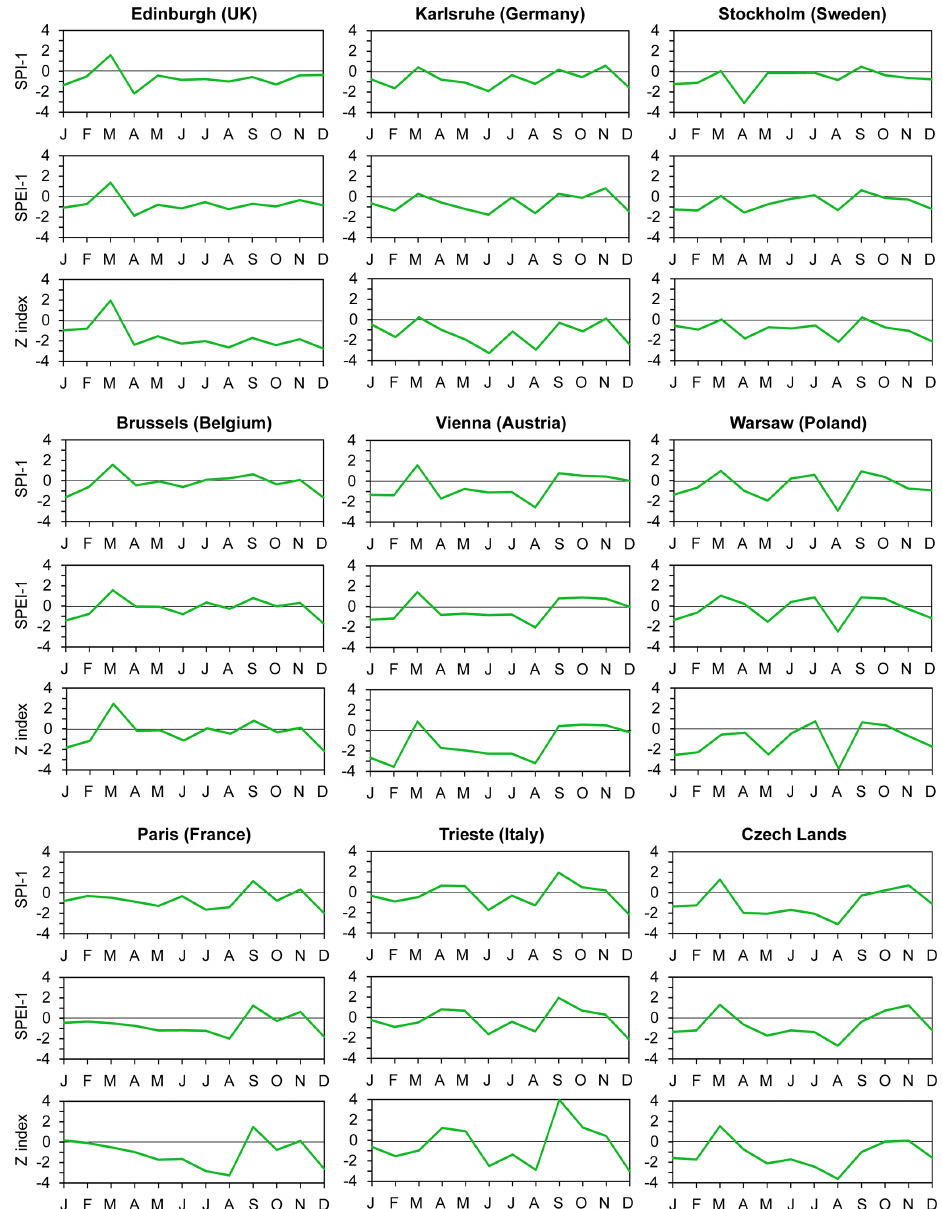
Figure 6. Annual variation in SPI-1, SPEI-1, and Z index for selected European stations and regions in